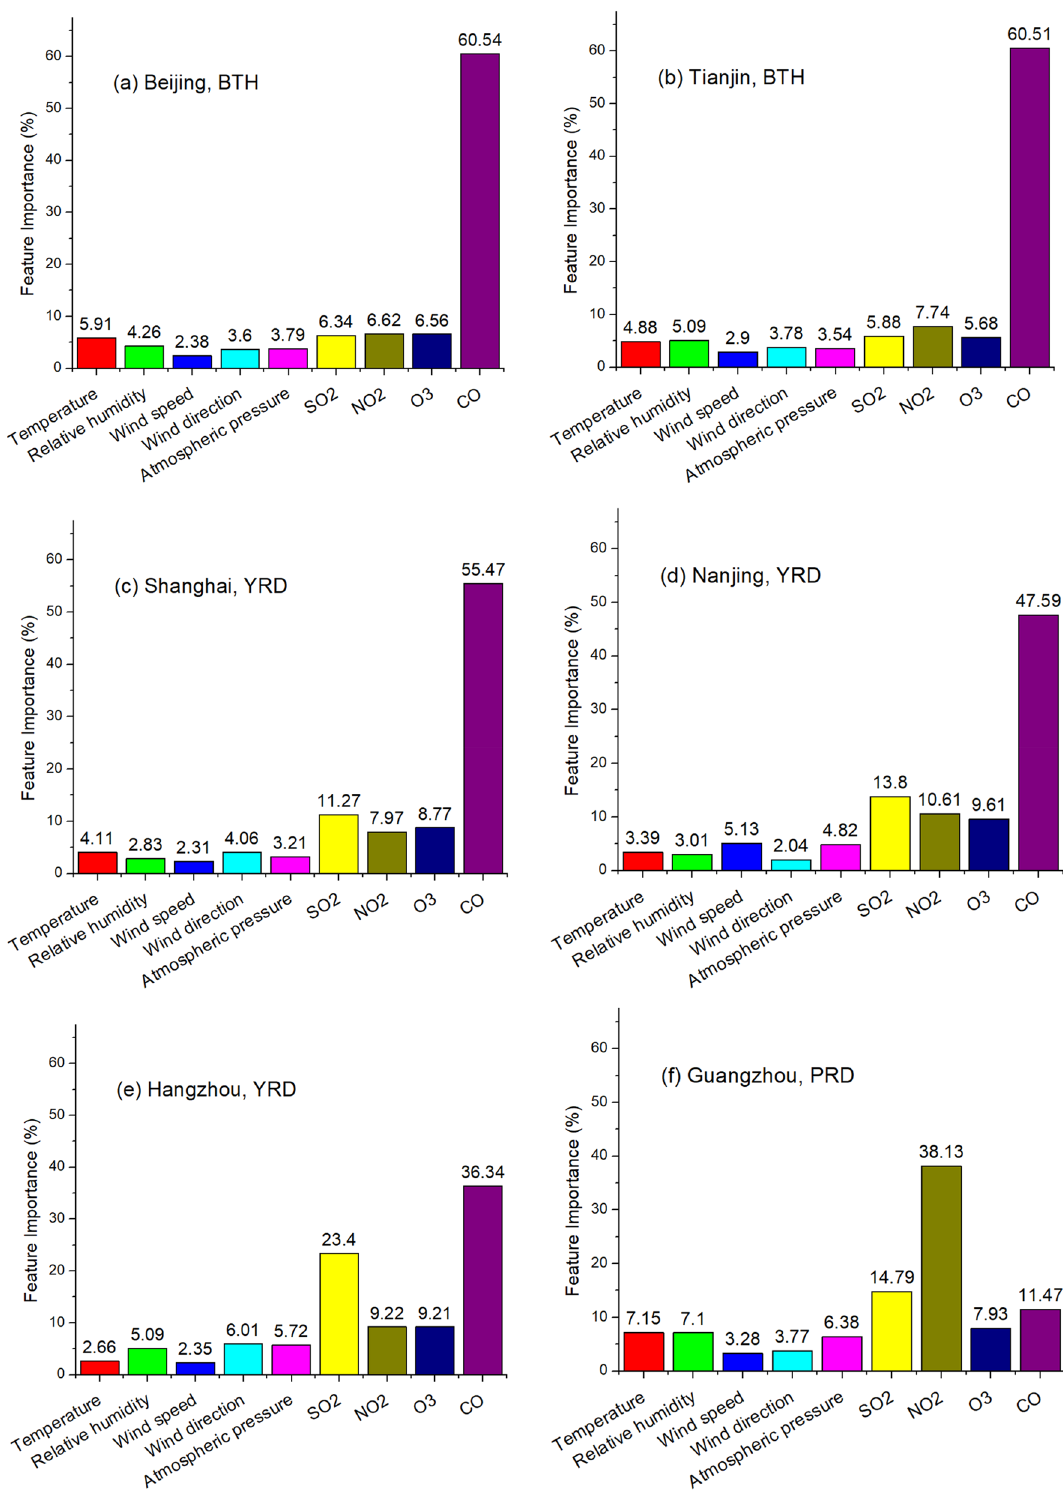
Figure 1. Feature Importance for PM 10 in wintertime from December 2014 to February